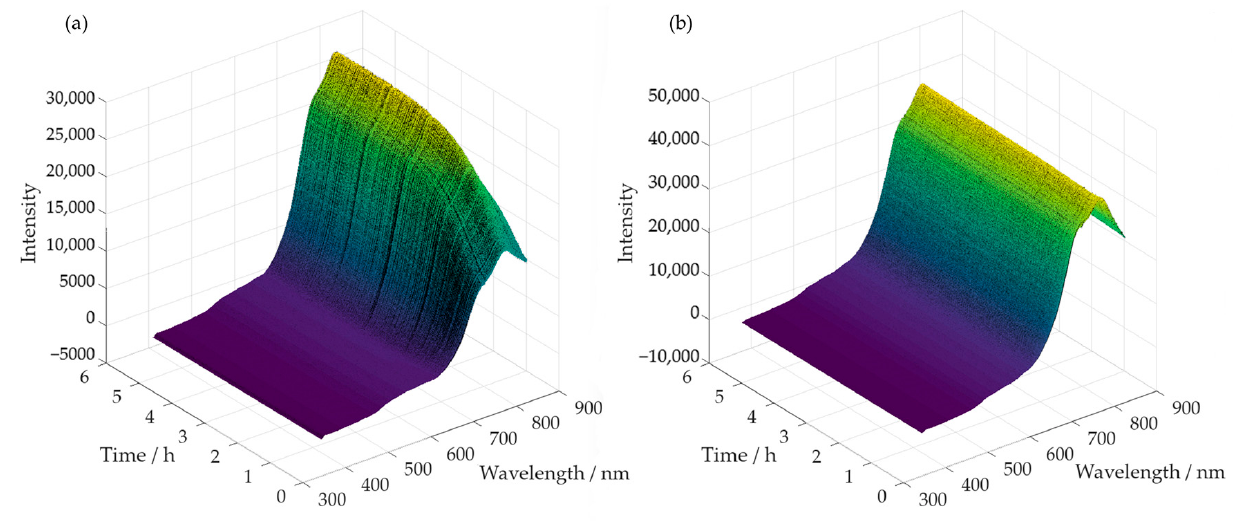
Figure 9. Spectra acquired along the methylolation of SLS ( a ) and HLS ( b ) at 60 °C.